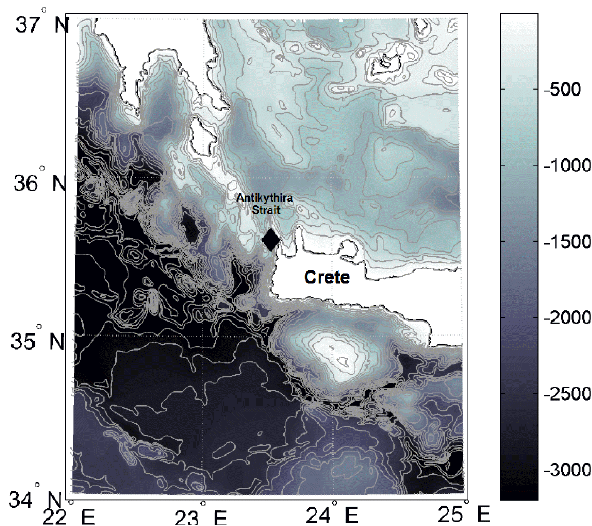
Fig. 13. Location of the monitoring site in the Cretan